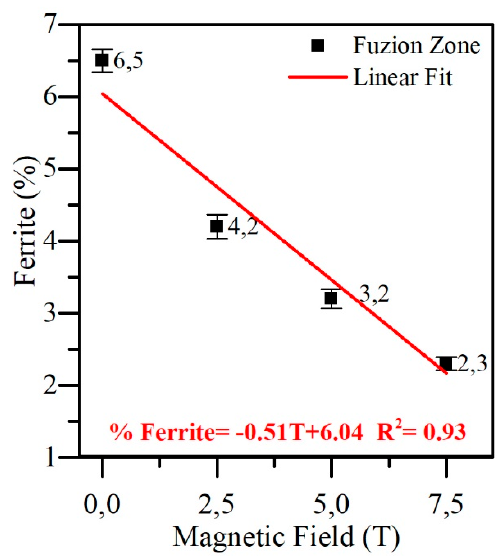
Figure 5. Variations of the external magnetic field versus the measured ferrite fraction volumes.